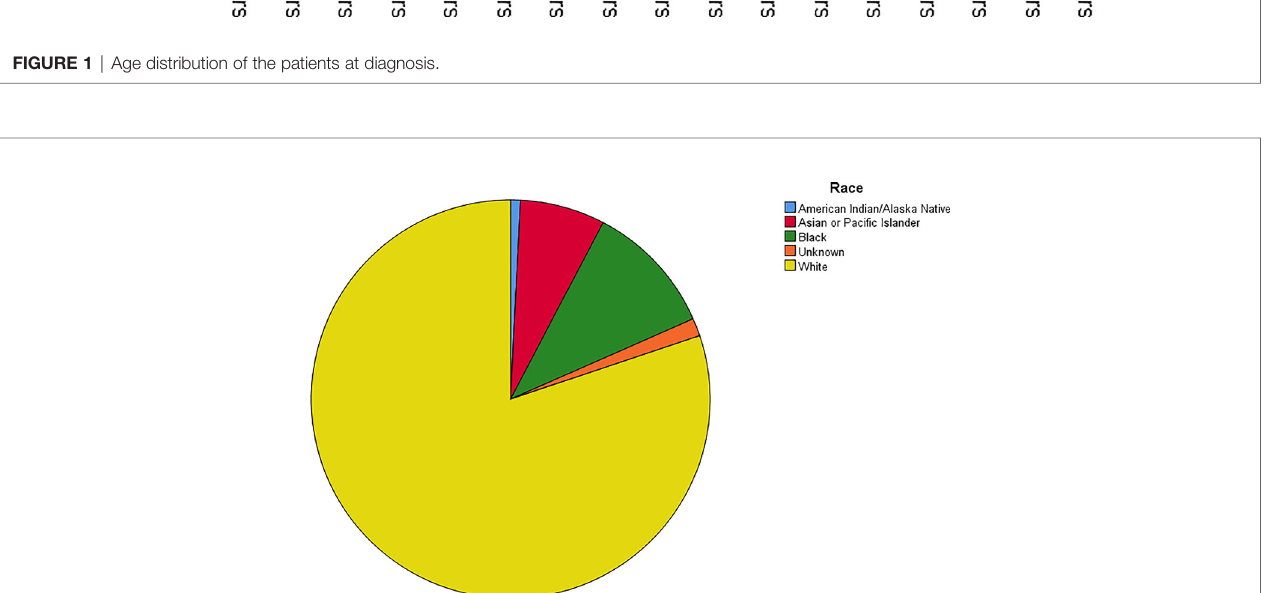
FIGURE 2 | Racial distribution of the